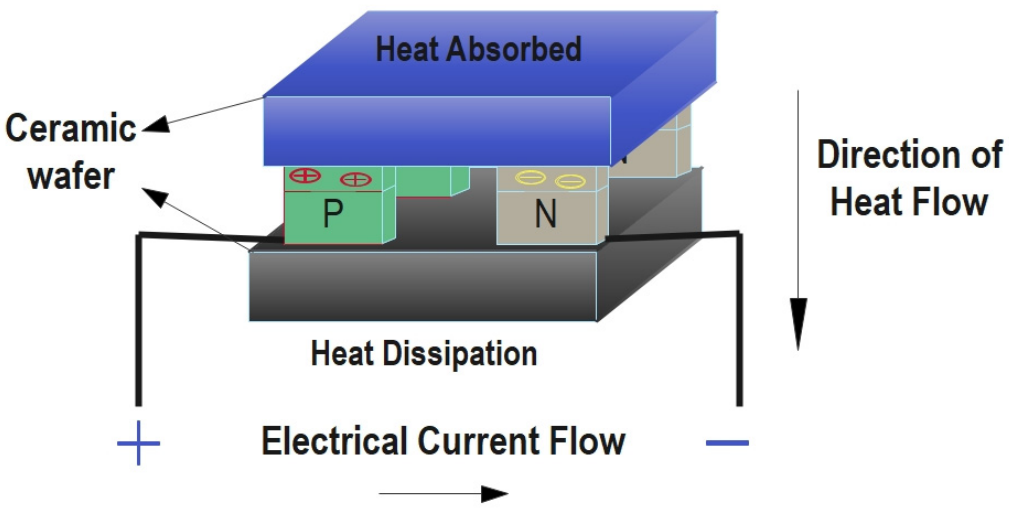
Figure 1. Schematic depiction of a TEG module.